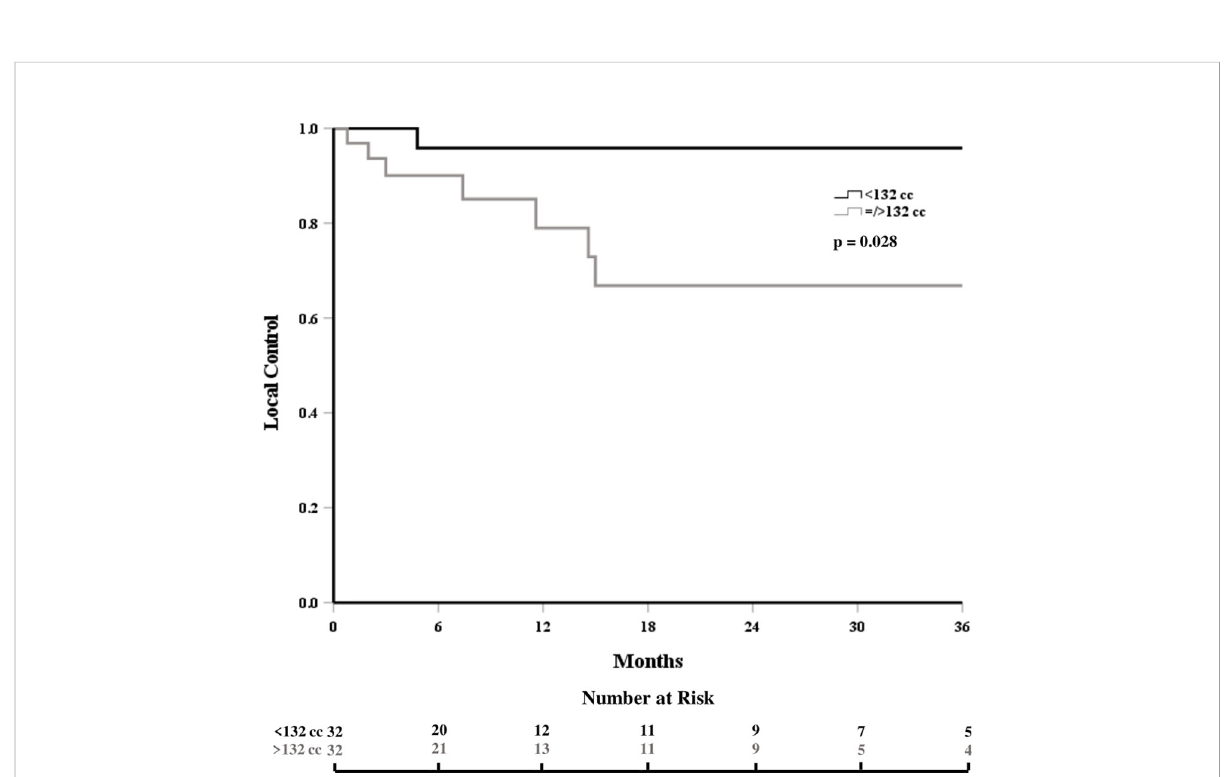
FIGURE 3 Local control, strati fi ed by volume of treated